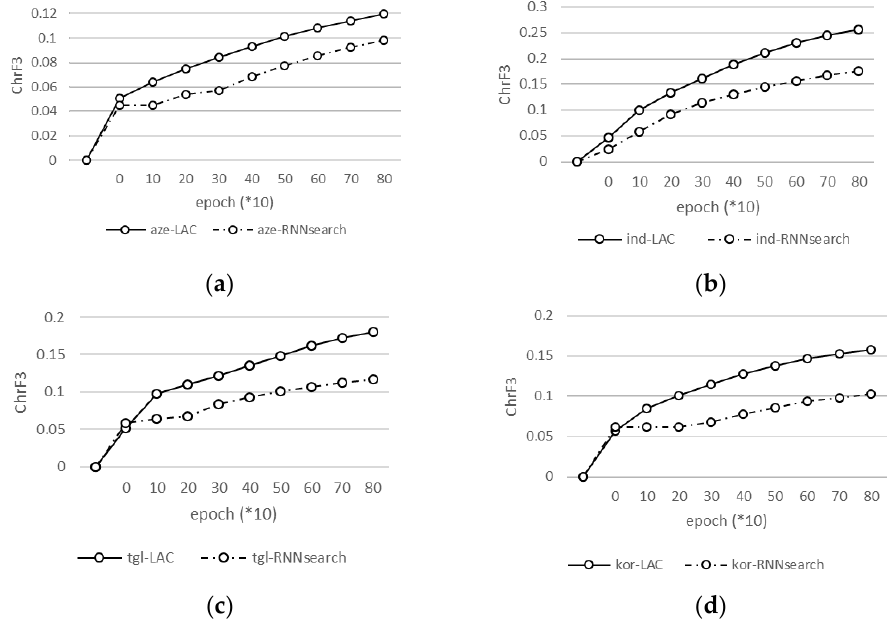
Figure 5. ChrF3 training curves for four languages: ( a ) aze-eng, ( b ) ind-eng, ( c ) tgl-eng, and ( d ) kor- eng. LAC-RNNsearch and RNNsearch are denoted by the solid and dotted lines, respectively.